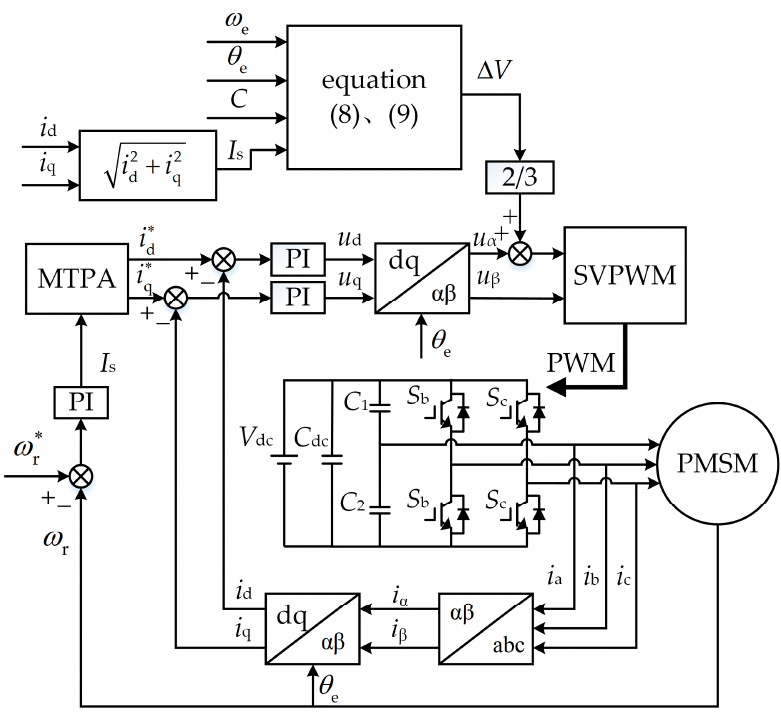
Figure 3. The block diagram of TPFS inverter-fed PMSM vector control.